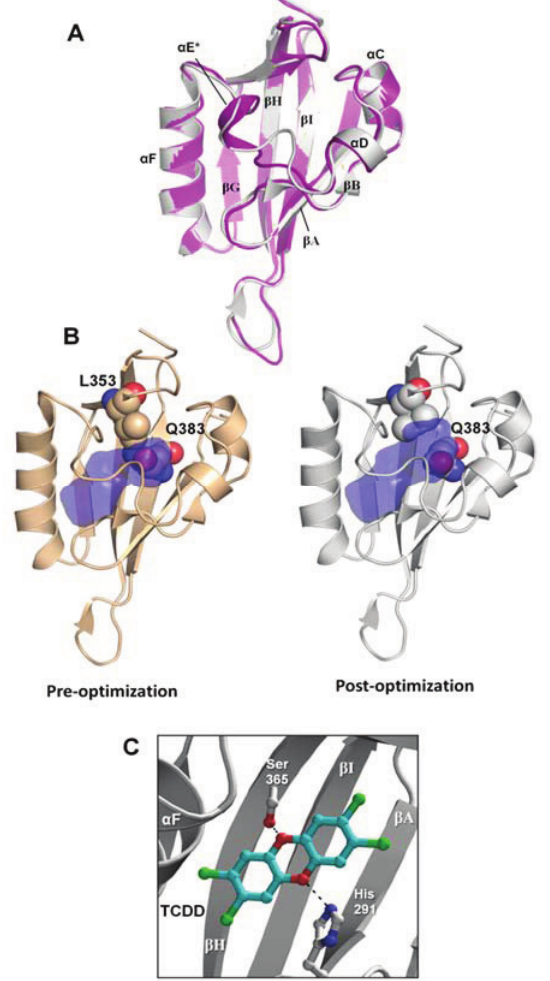
Figure 2. Agonist-optimized model of human AHR PAS-B. ( A ) Comparison of the agonist-optimized model (grey) with its template structure hypoxia inducible factor 2(cid:2) (HIF-2(cid:2)) Per/ARNT/Sim (PAS)-B (purple, PDB code 1p97). Standard PAS-B secondary structures are labeled. The helix (cid:2)E is distinguished with an (*) because it adopts nearly helical geometry in the agonist-optimized model. The highest energy strain in the agonist-optimized model occurs at residues Phe324 ((cid:2)E), Leu370 ((cid:5)H), and Ile380 ((cid:5)I). ( B ) The AHR PAS-B homology models pre-optimization and post-optimization are shown. The binding pocket is displayed in blue, with the pocket calculated as the solvent-accessible surface area using a spherical probe with a radius of 1.4 Å. Residues Leu353 and Gln383 are displayed as spheres and colored with oxygens red, nitrogens blue, and carbons brown or grey. ( C ) The docking orientation of 2,3,7,8-tetrachlorodibenzo-p-dioxin (TCDD) in the agonist-optimized model is shown, which forms hydrogen bonds to Ser365 and